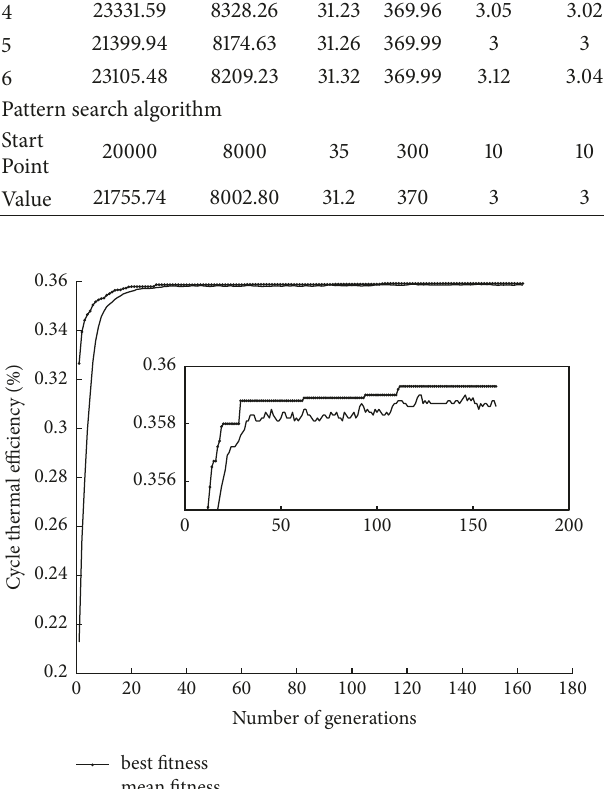
Figure 7: Convergence curve of thermal efficiency with generation by genetic algorithm.